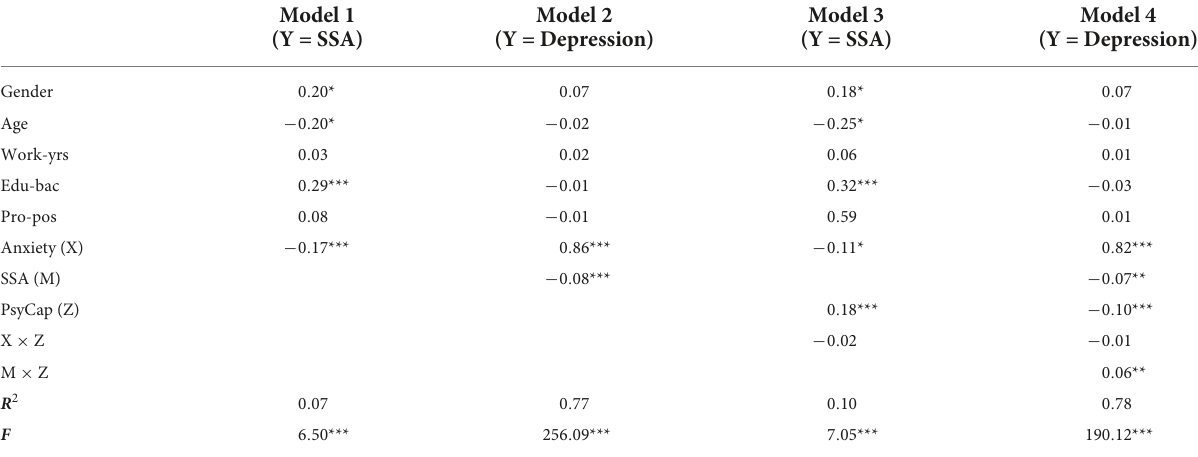
TABLE 3 Model characteristics for moderated mediation analysis.